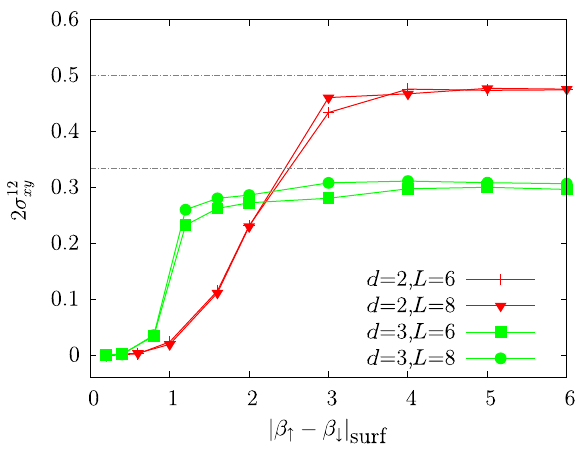
FIG. 16. Surface Hall conductivity at a boundary of a SET phase for different values of d , in units of e 2 =h . We see that the Hall conductivity is given by 1 =d . Both surfaces have been averaged over to improve statistics. Dashed lines are drawn at 1 =d to guide the eye. Data are taken with K ¼ 0 . 2 , λ ¼ 8 . Different values of β are used for different values of d , since the phase bulk diagram changes as d changes (see for example, Fig. 14) and β bulk needs to be chosen so that the system is in the topological